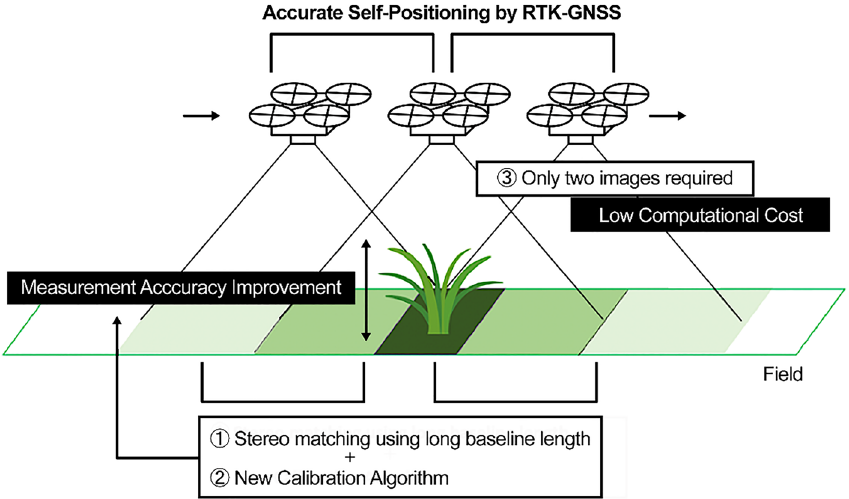
Figure 1. Overview of the proposed